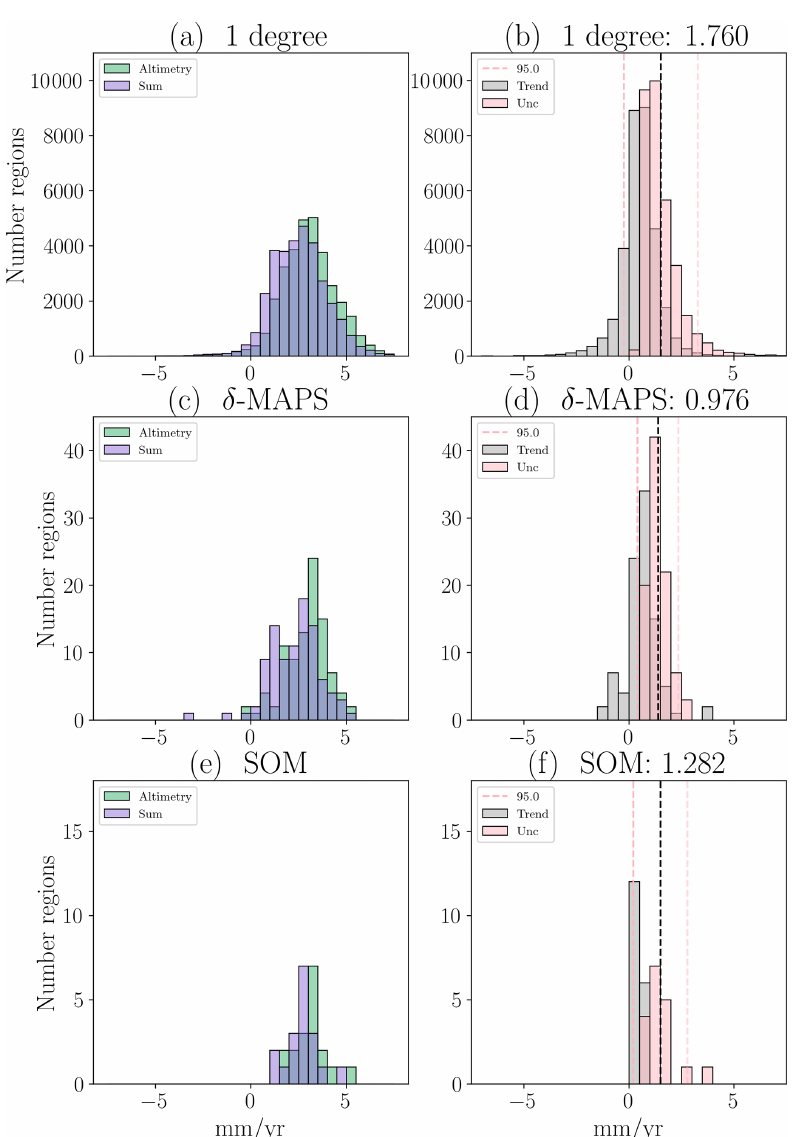
Figure A3. Distribution histograms of the altimetry ( a, c, e , green blocks), sum of the components ( a, c, e , purple blocks), and residuals trend ( b, d, f , grey) and uncertainty (right columns, pink) for the 1 × 1 ◦ budget (a, b) , δ -MAPS domains (c, d) , and SOM domains (e, f) . The dashed pink lines indicate the 95% confidence interval of the residuals uncertainty, with the interval width reported in the panel titles, and was used as a reference for the residuals scatters in Fig.